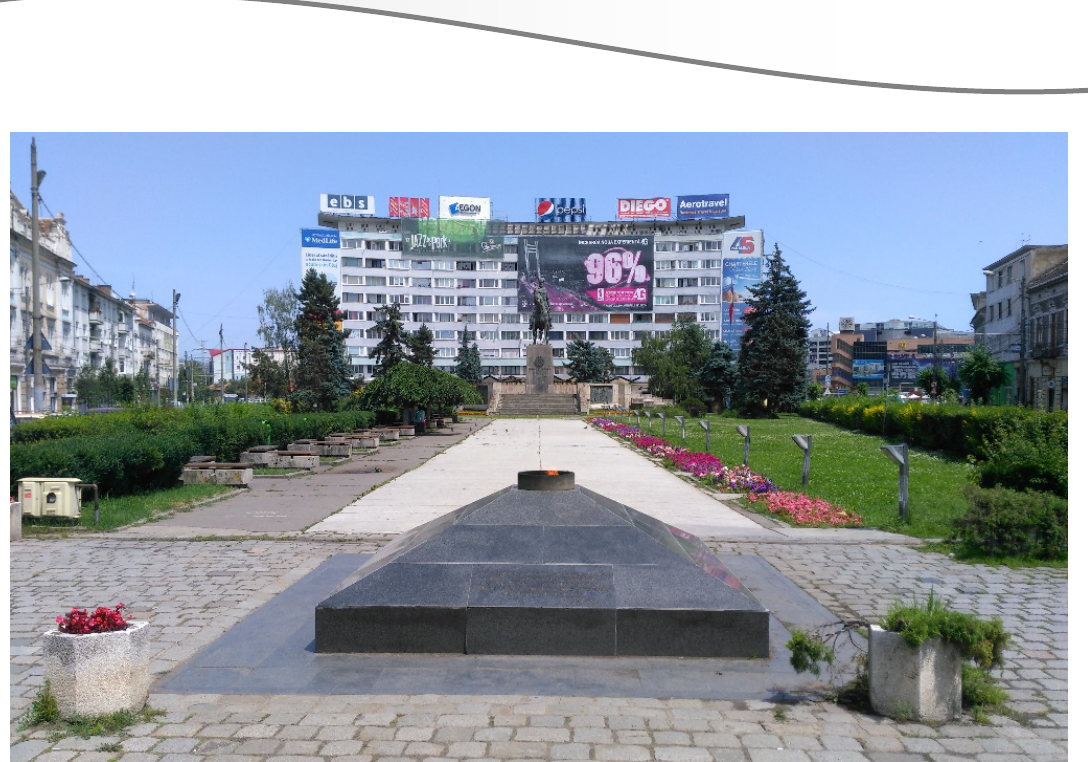
Figure 6 : Mihai Viteazul Square – view from the west Source: Emanuel- Cristian ADOREAN,